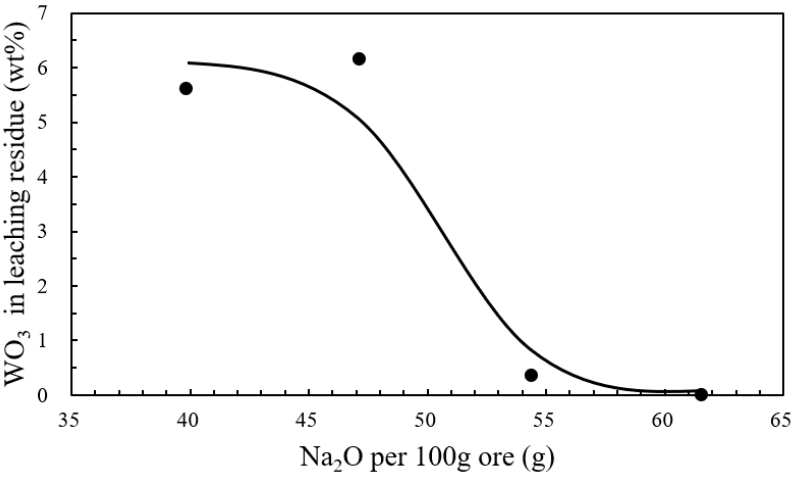
Figure 8. Effect of Na 2 O on WO 3 in leaching residue at 1200 °C in argon with 30% SiO 2.